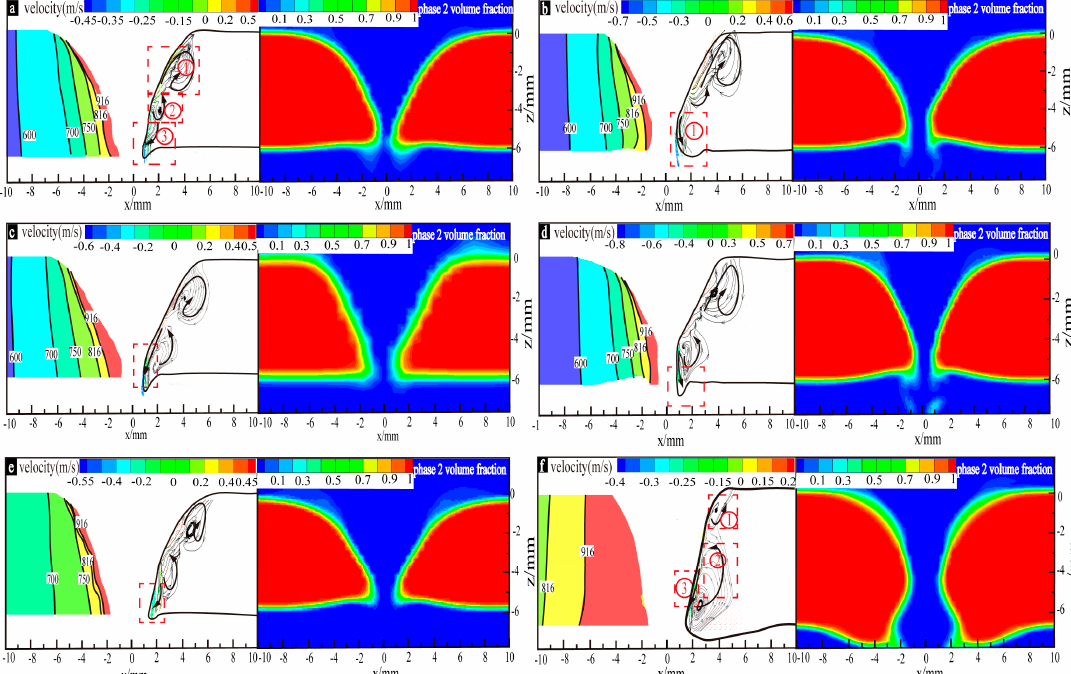
Figure 14. Weld pool flow and phase distribution in the critical state of the keyhole perforation for case ( a – f ) .